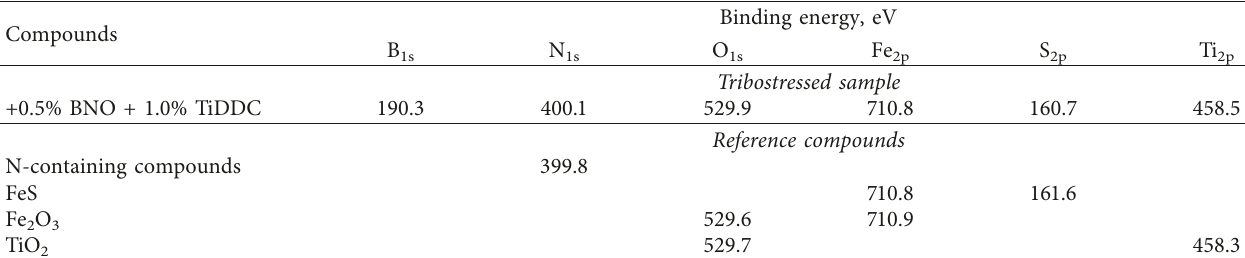
Table 3: Binding energy of elements on the worn surface and the main